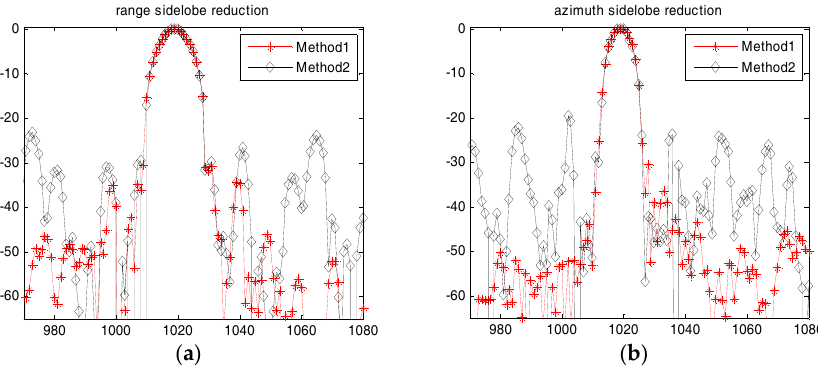
Figure 14. Range and azimuth profiles comparison between the two methods ( a ) Range profiles; ( b ) Azimuth profiles.